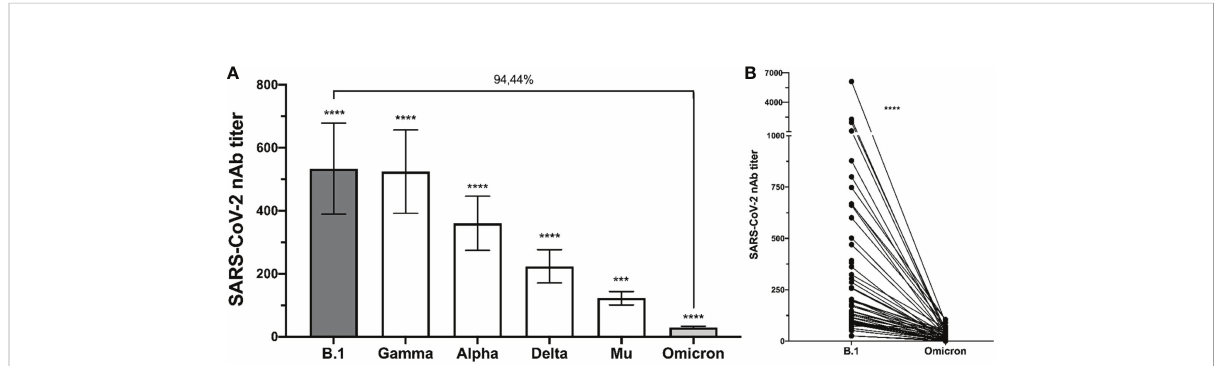
FIGURE 1 Decrease in nAbs against Omicron in comparison to other variants. The comparison between the neutralizing antibody titers of the individuals after six months of being fully vaccinated is shown. (A) bulk results; the statistical analysis was performed using Kruskal-Wallis test with a con fi dence level of 95% and post hoc tests (or multiple benchmarks) HDS of Dunn. **** p<0.0001, *** p<0.001 for each variant compared with the Omicron. (B) individual results comparing B.1 and Omicron variant; the statistical analysis was performed by Wilcoxon ’ s